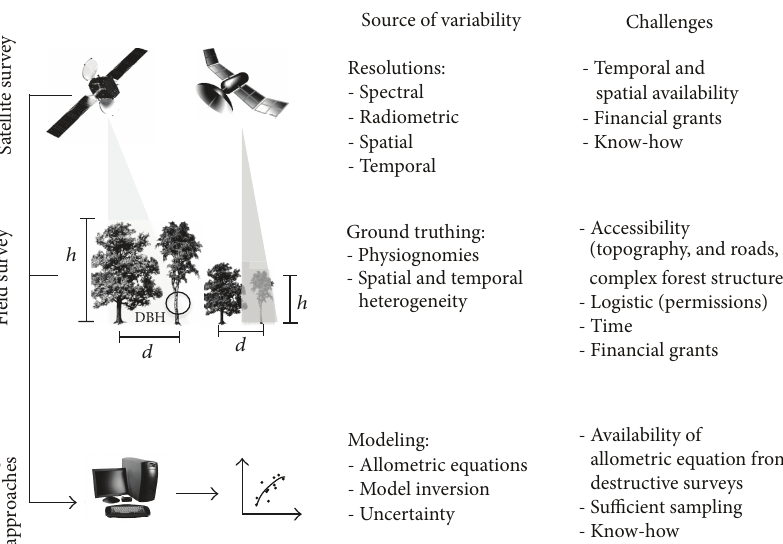
Figure 5: Source of variability and challenges related to each stage of aboveground biomass estimation and